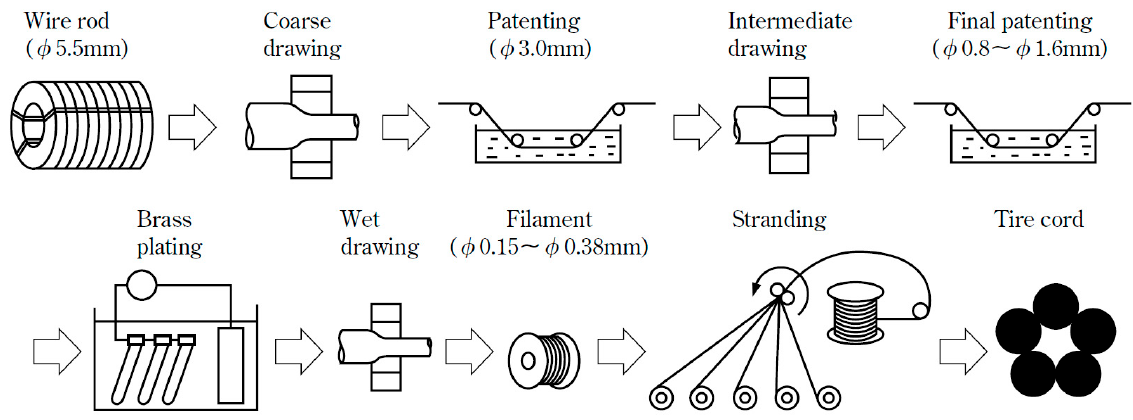
Figure 2. Drawing process diagram of a steel cord and steel wire saw. Reprinted with permission from ref. [2]. Table 1. The typical chemical composition of a steel cord and saw wire rod.